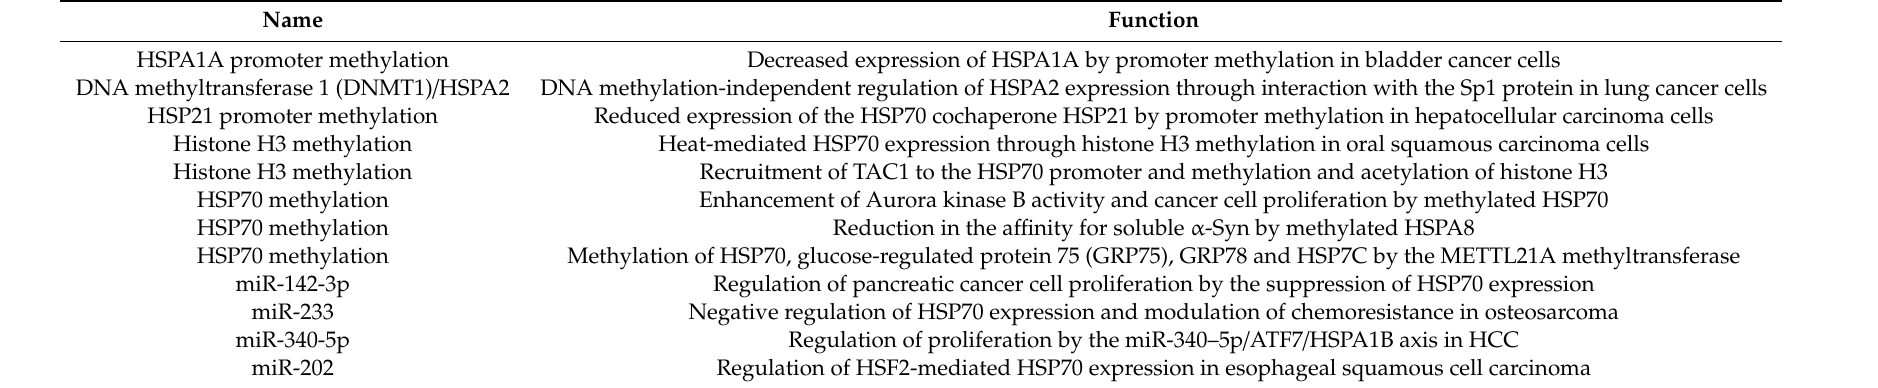
Table 2. Epigenetic regulations of HSP70 family member expression and